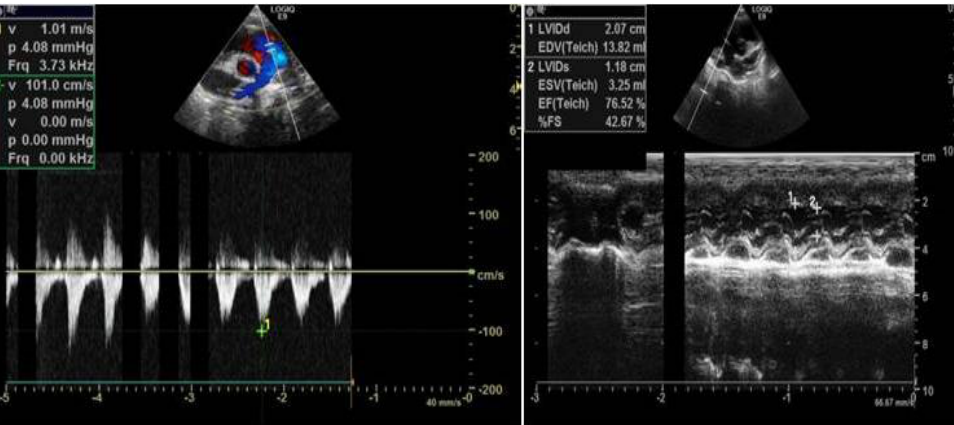
Figure 2. Proband’s heart color ultrasound.